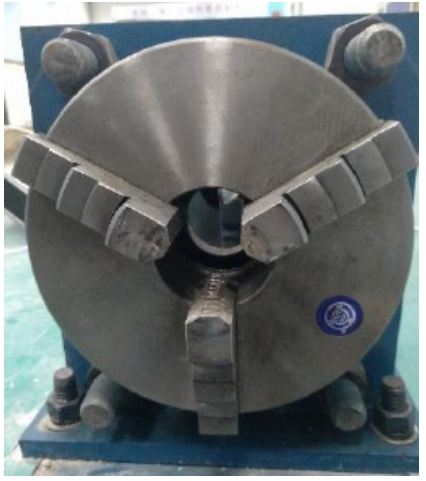
Figure 8. Chuck of